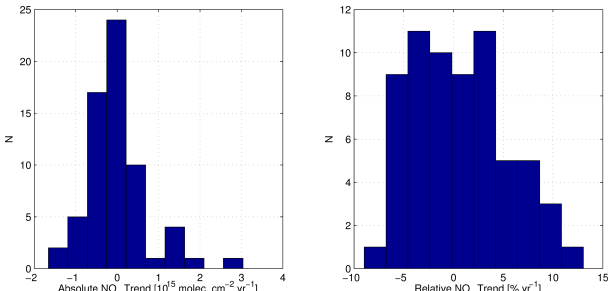
Figure 4. Histograms of absolute (left panel) and relative (right panel) tropospheric NO 2 trends over large urban agglomerations worldwide. The relative trends were computed with respect to the long-term average concentration computed over the entire time se- ries at each grid cell